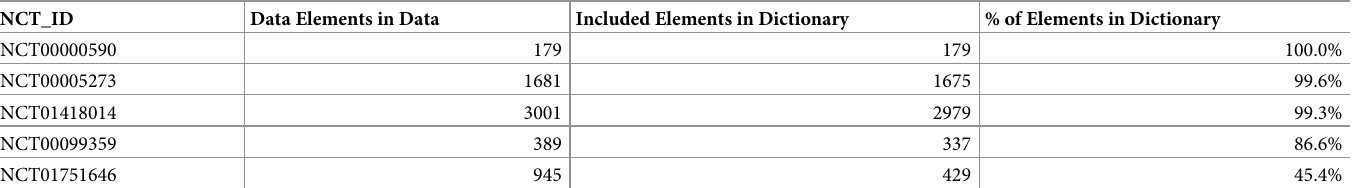
Table 4. Proportion of data elements found in IPD data that are also present in the data dictionary.